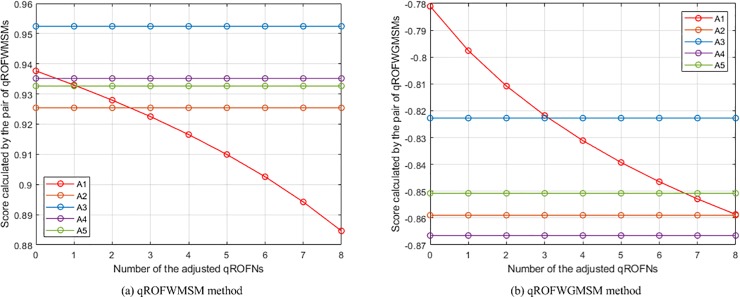
The changes of the places of A1 in the rankings of the WMSM and WGMSM methods.